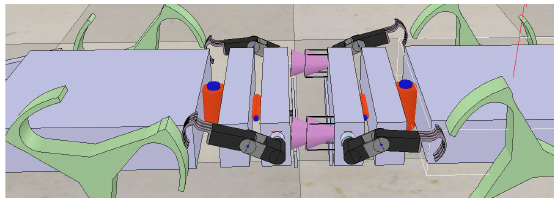
Figure 6. Coupling mechanism for the assembly of two